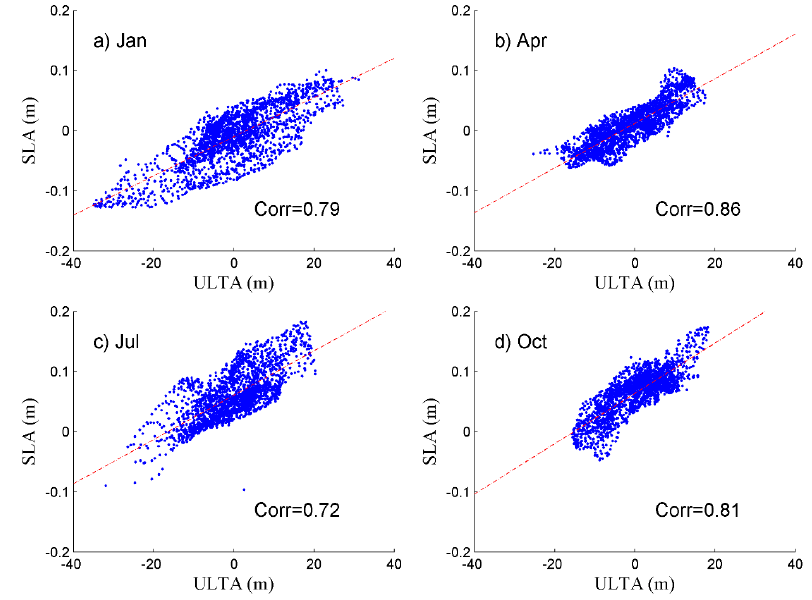
Figure 4. The scatter plots of SLA and ULTA calculated by 25 kg/m 3 isopycnal in January, April, July and October ( a – d ). The line of best fit is represented by the red dashed line.